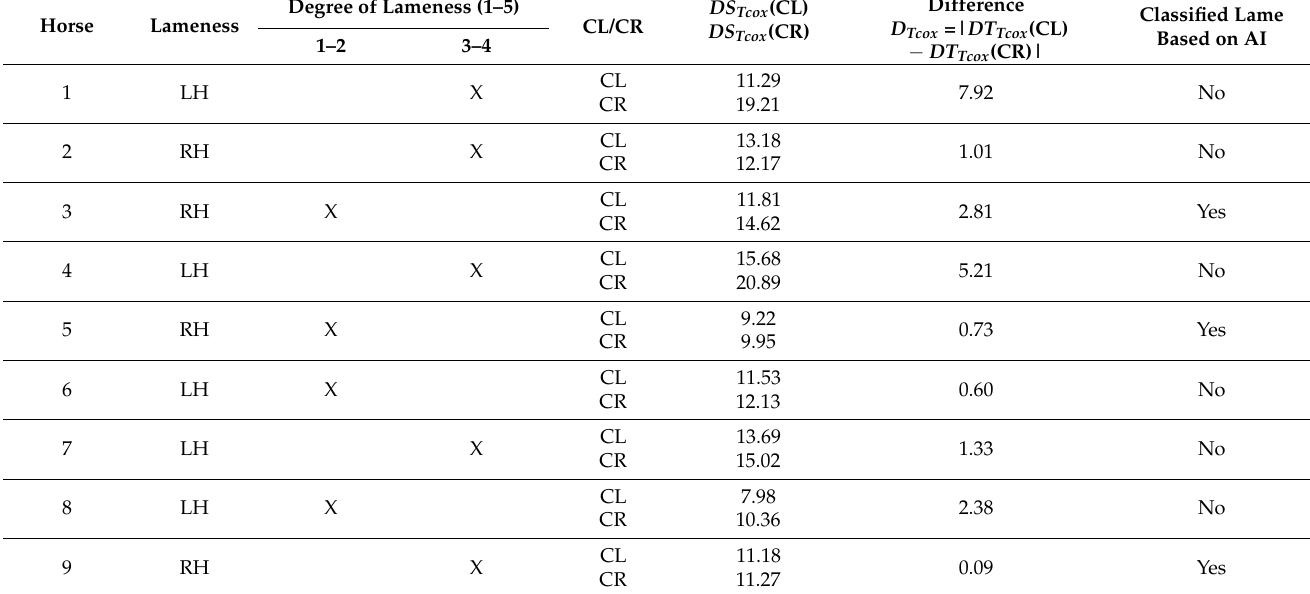
Table 3. Tuber coxae reference point—Hindlimb-lame horses.